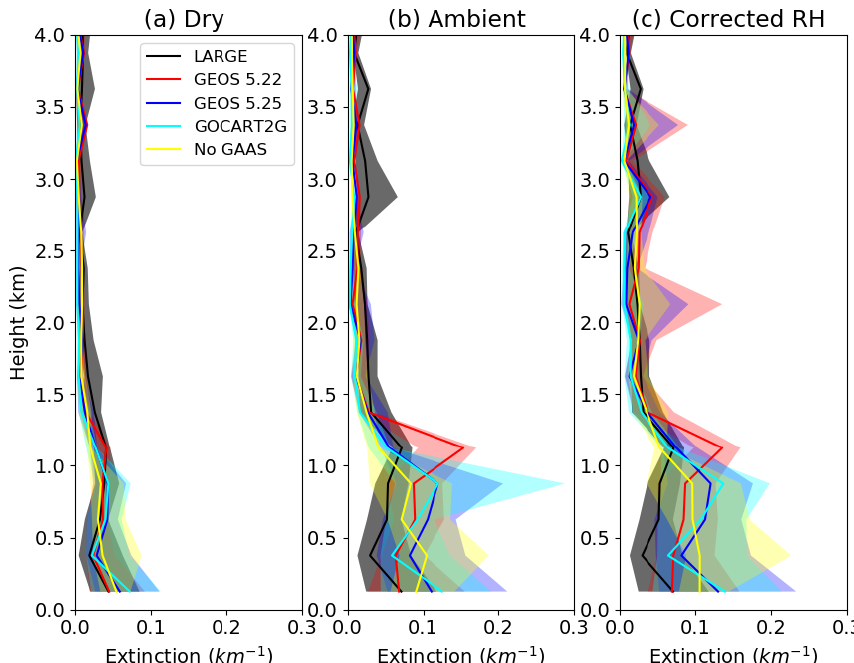
Figure 6. Median extinction at 532nm for all research flights from LARGE and GOCART2G for (a) ambient, (b) dry, and (c) observation- corrected relative humidity. Profiles are shaded between the 25th and 75th